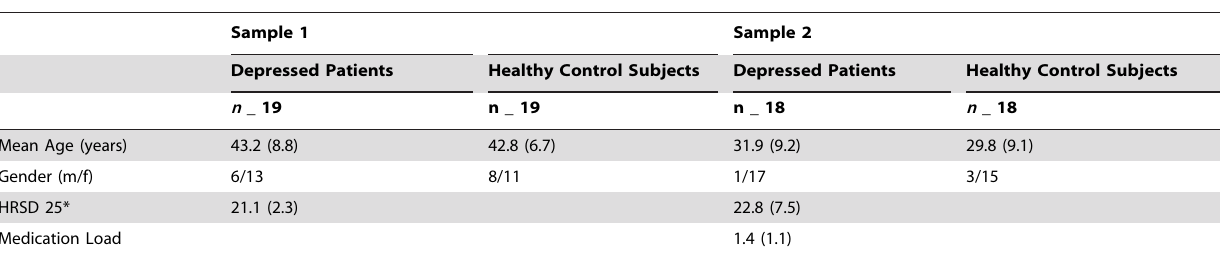
Table 1. Demographic Features and Severity of